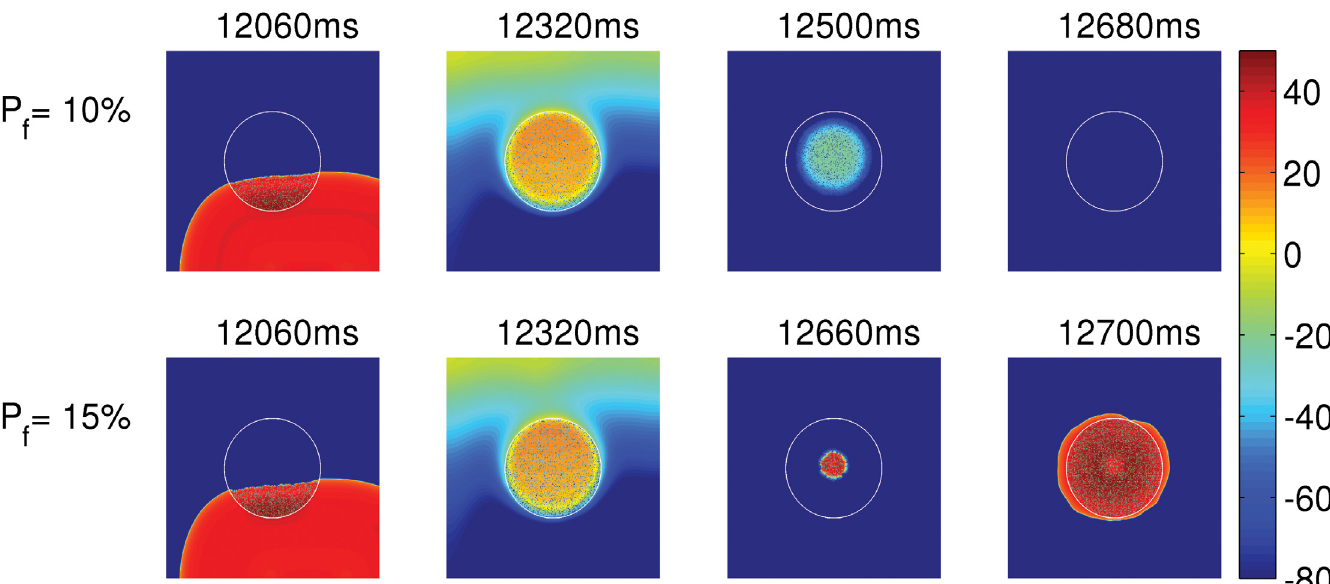
Fig 7. The dependence of PVC triggerings on the degree of fibrosis. Pseudocolor plots of V m illustrating the triggering of PVCs with 15% fibrosis (bottom panel) and the absence of PVCs with 10% fibrosis (top panel) in an EAD clump with radius R =